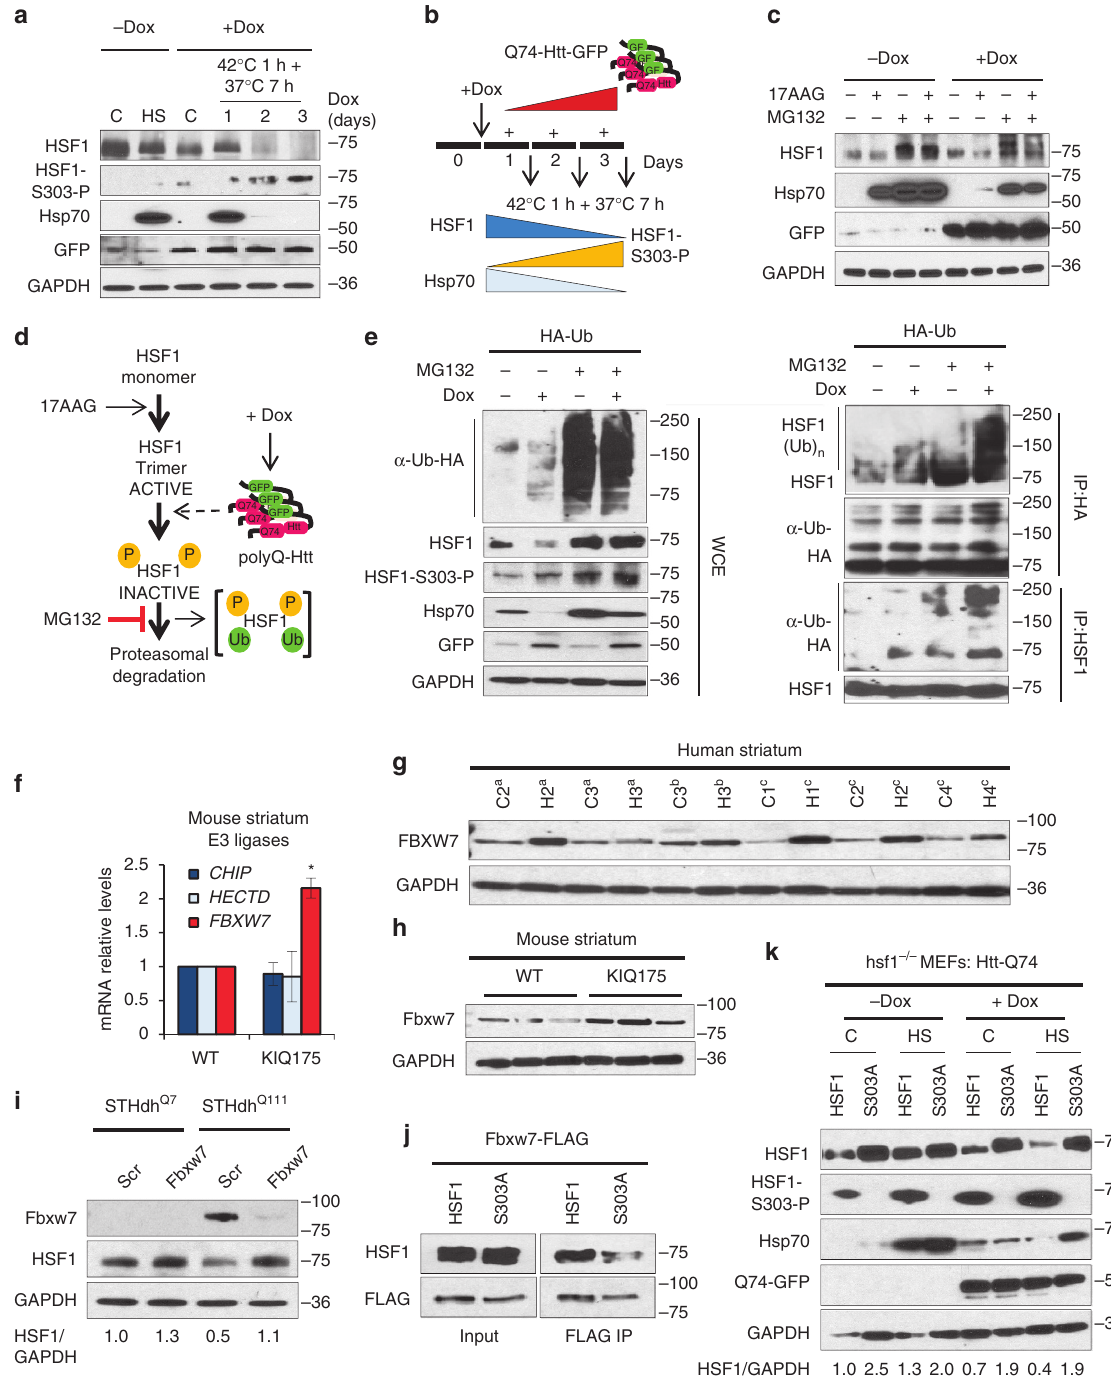
Figure 2 | Proteasomal HSF1 degradation in HD is mediated by Phospho-S303/S307. ( a , b ) PC12 cells expressing Htt-Q74 for 1, 2 or 3 days followed by Heat Shock (HS) and recovery as indicated. Control and HS in the absence of Dox correspond to cells incubated during 3 days at 37 (cid:2) C. ( c ) Htt-Q74 cells Dox-induced or not for 3 days and exposed to 2 m M 17-AAG and/or MG132 (5 m M) for 6h and extracts immunoblotted with the indicated antibodies. ( d ) Diagram of the effects of 17-AAG and MG132 treatment and Htt-Q74 expression in HSF1. ( e ) Htt-Q74 cells transfected with human influenza haemagglutinin-ubiquitin (HA-Ub) plasmid Dox induced or not and treated with 5 m M MG132 treatment for 6h. Whole-cell extract and HA immunoprecipitated (IP:HA) and HSF1 immunoprecipitated samples (IP:HSF1) were immunoblotted as indicated. ( f ) Transcript levels for indicated E3 ligases evaluated by qRT-PCR from striatum of WT and KIQ175 mice at 6 months. Error bars represent ± s.e.m., ( n ¼ 3). Unpaired t -test, * P o 0.05. ( g ) Human striatum samples from HD patients and controls and ( h ) Mouse striatum from 12 months old WTand KIQ175 mice were immunoblotted for HSF1 and Fbxw7. ( i ) Fbxw7 siRNA in STHdh Q7 and STHdh Q111 cells using scrambled RNA (Scr) as control. HSF1 was quantified using Quantity One image software and normalized using GAPDH as loading control and referenced to control at 37 (cid:2) C in the non-pathogenic STHdh Q7 . ( j ) hsf1 (cid:2) / (cid:2) MEFs transfected with WT HSF1 or S303A mutant and Fbxw7-FLAG; samples immunoprecipitated with anti-FLAG and HSF1 detected. ( k ) hsf1 (cid:2) / (cid:2) MEFs expressing Dox-inducible Htt-Q74- GFP transfected with WT HSF1 or HSF1-S303A HS and 1h recovery at 37 (cid:2) C for 7h. HSF1 was quantified using Quantity One image software and normalized using GAPDH as loading control and referenced to control ( (cid:2) Dox) expressing WT HSF1. See Supplementary Fig. 9 for uncropped immunoblots. NATURE COMMUNICATIONS|8:14405|DOI: